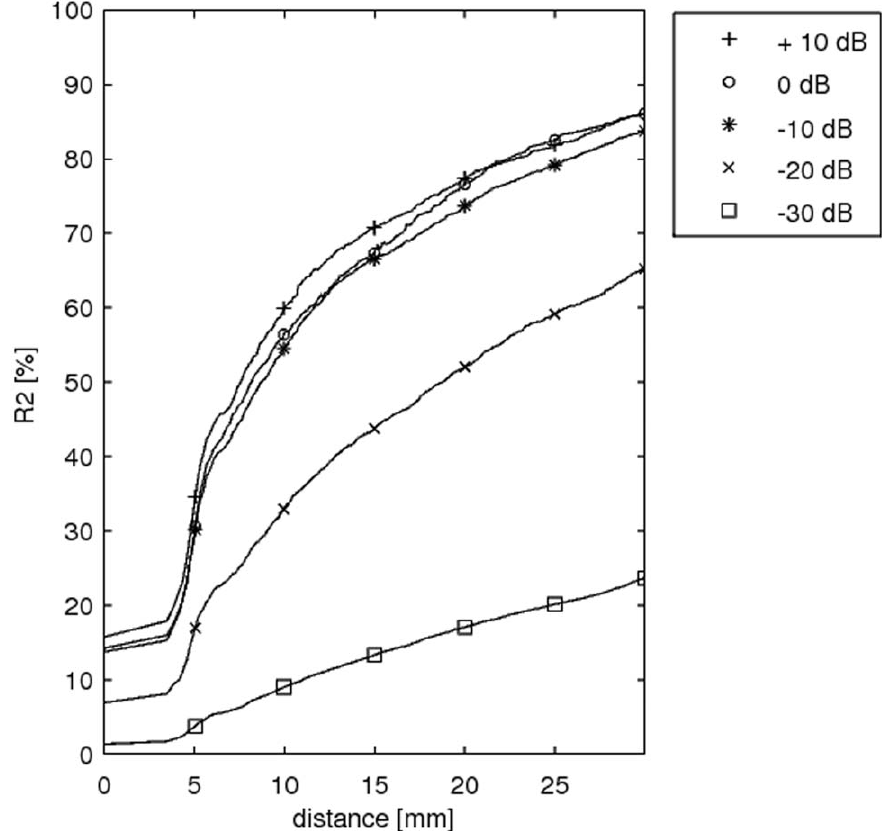
Figure 8. Example of curves of temporal variance explained by the source reconstruction (R 2 ). The R 2 value reported by SPM includes all vertices in the cortical mesh. Only the vertices located within the given search-size (x axis; 3 to 30 mm) were considered to generate time-courses. One line plot is calculated for each SNR ( 2 30 to + 10 dB, in 10 dB steps). The Temporal Accuracy Index (TAI) for a given search-size is considered as the R 2 value at that distance.